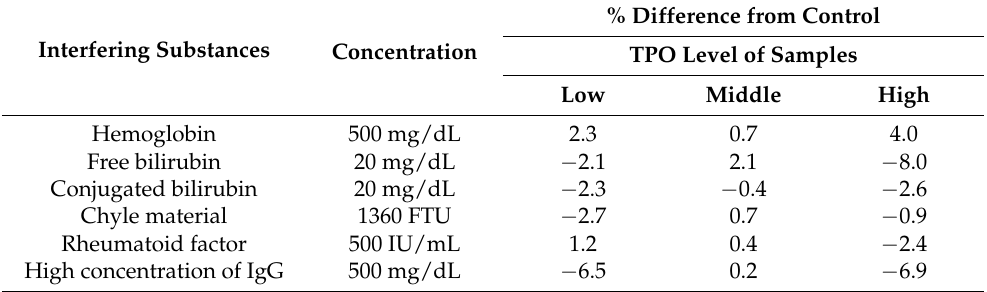
Table 4. Evaluation of interfering substances.